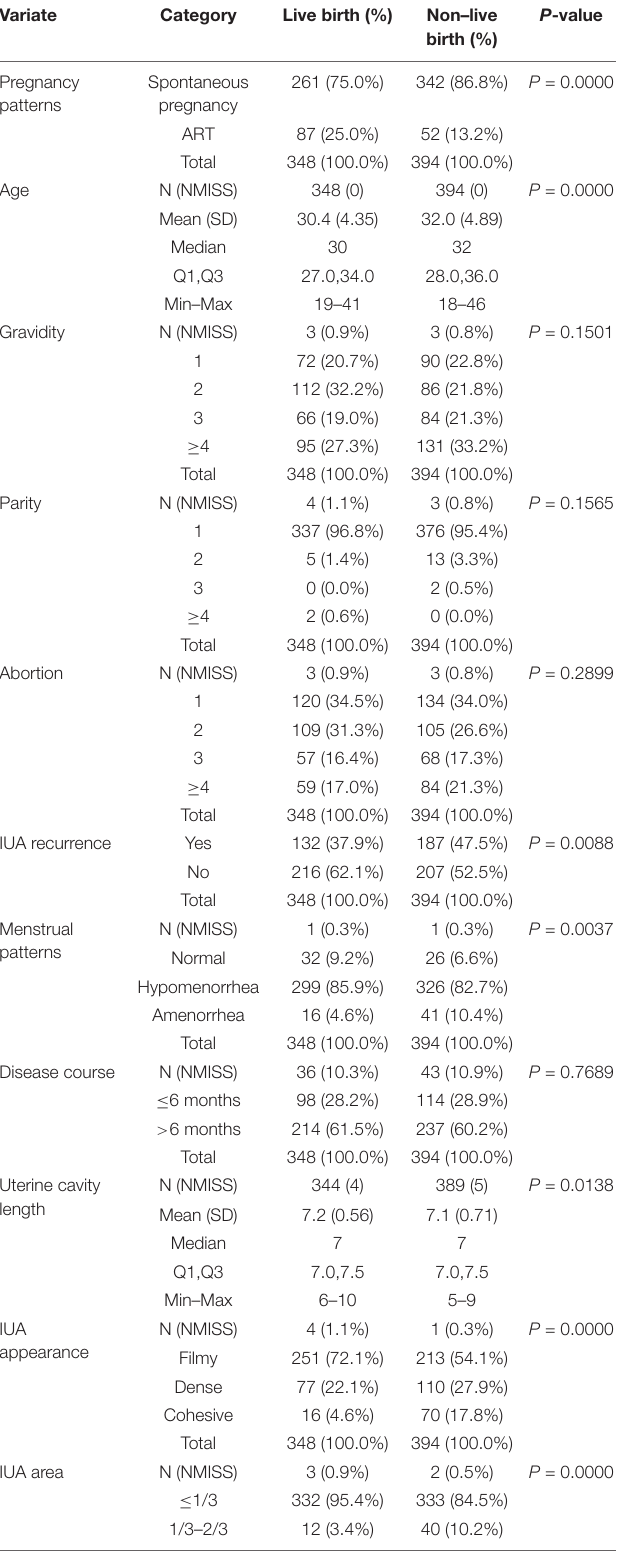
TABLE 1 | Related factors affecting live birth rate of fertility-desiring women with IUAs. Variate